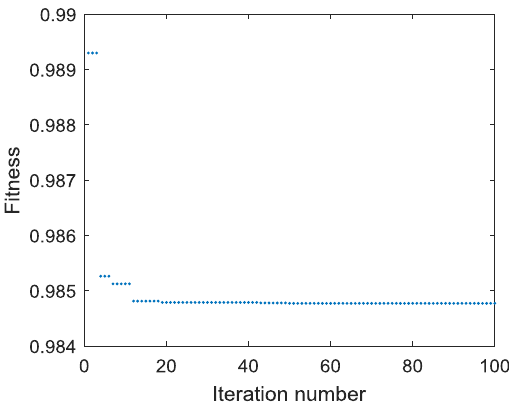
Figure 13. Fitness values in the optimization process.